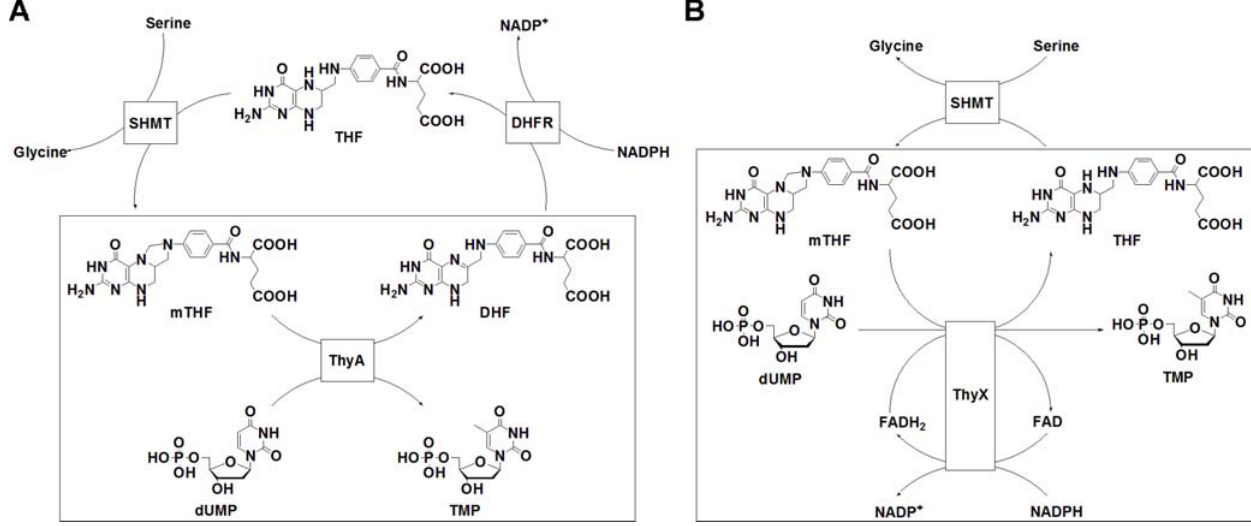
Figure 1. Different reaction complexities of ThyA and ThyX. (A) ThyA converts dUMP to TMP using mTHF as a cofactor. mTHF is regenerated by dihydrofolate reductase (DHFR) and serine hydroxymethyltransferase (SHMT). (B) ThyX converts dUMP to TMP using mTHF, NADPH, and FAD as cofactors. mTHF is regenerated by SHMT.